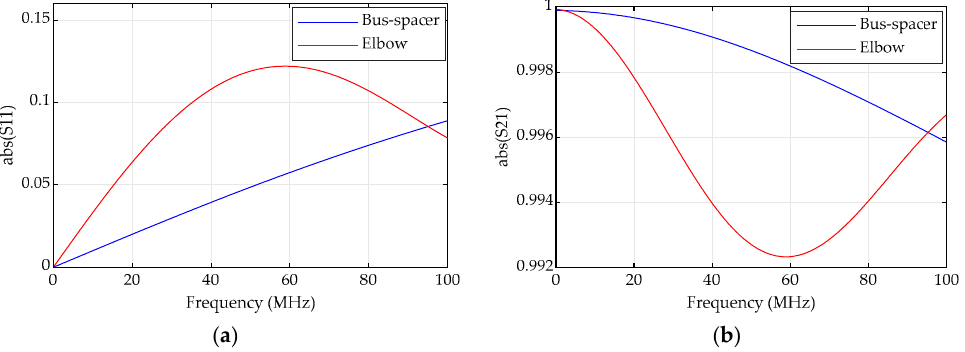
Figure 2. Bus-spacer and elbow scattering parameters (S-parameters): ( a ) S11 (reflectance); and ( b ) S21 (transmittance).